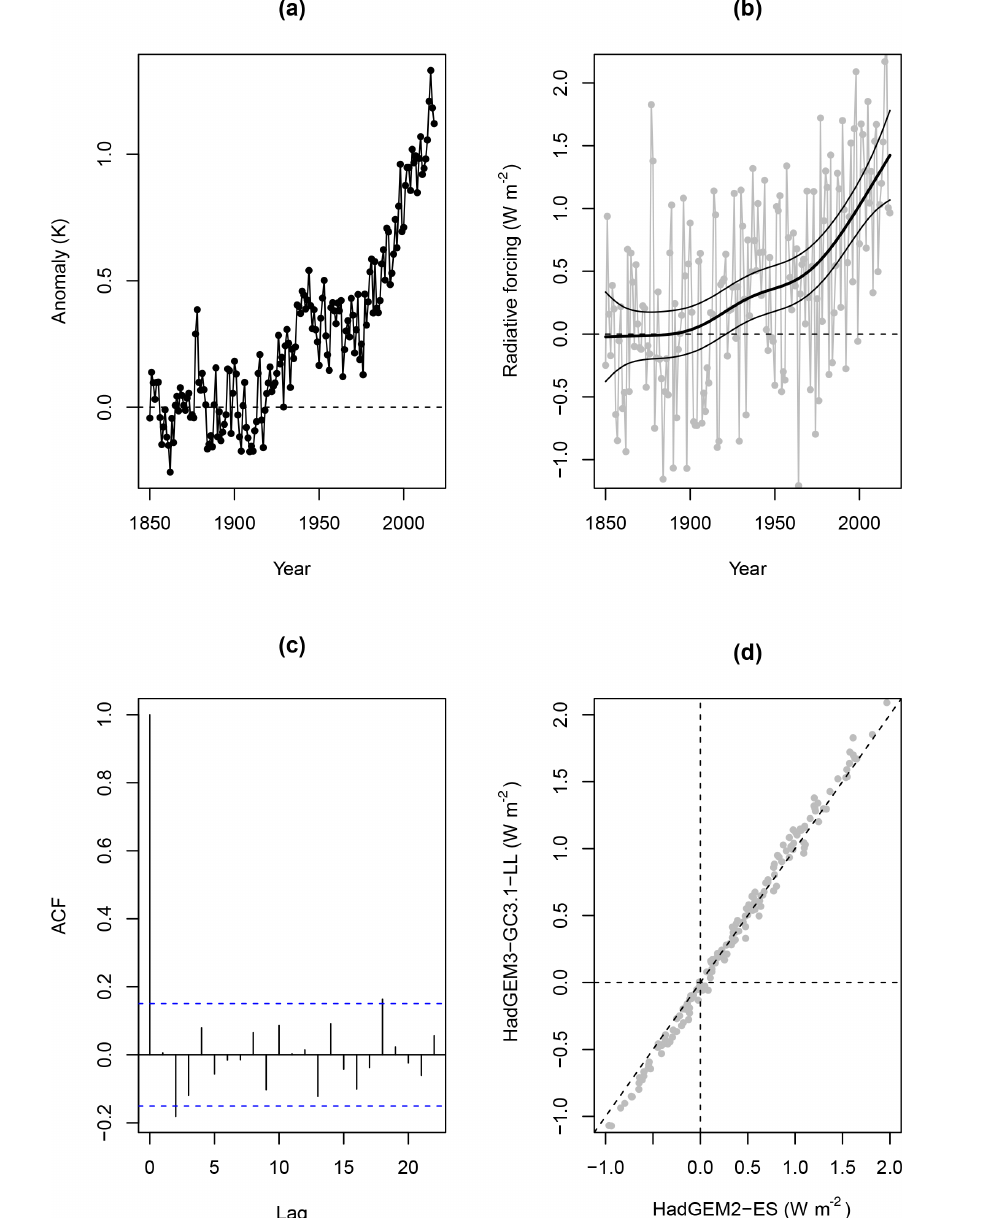
Figure 4. HadGEM3-GC3.1-LL three-box ARMA filter reconstruction of historical radiative forcing. Panel (a) is the Cowtan and Way 2.0 temperature series; (b) is the corresponding filtered forcing series, with an estimated trend and 95% confidence intervals from a generalized additive model (GAM) fit; (c) is the sample autocorrelation function (ACF) of the GAM residuals; (d) shows how estimates from the two models vary over the range of forcing